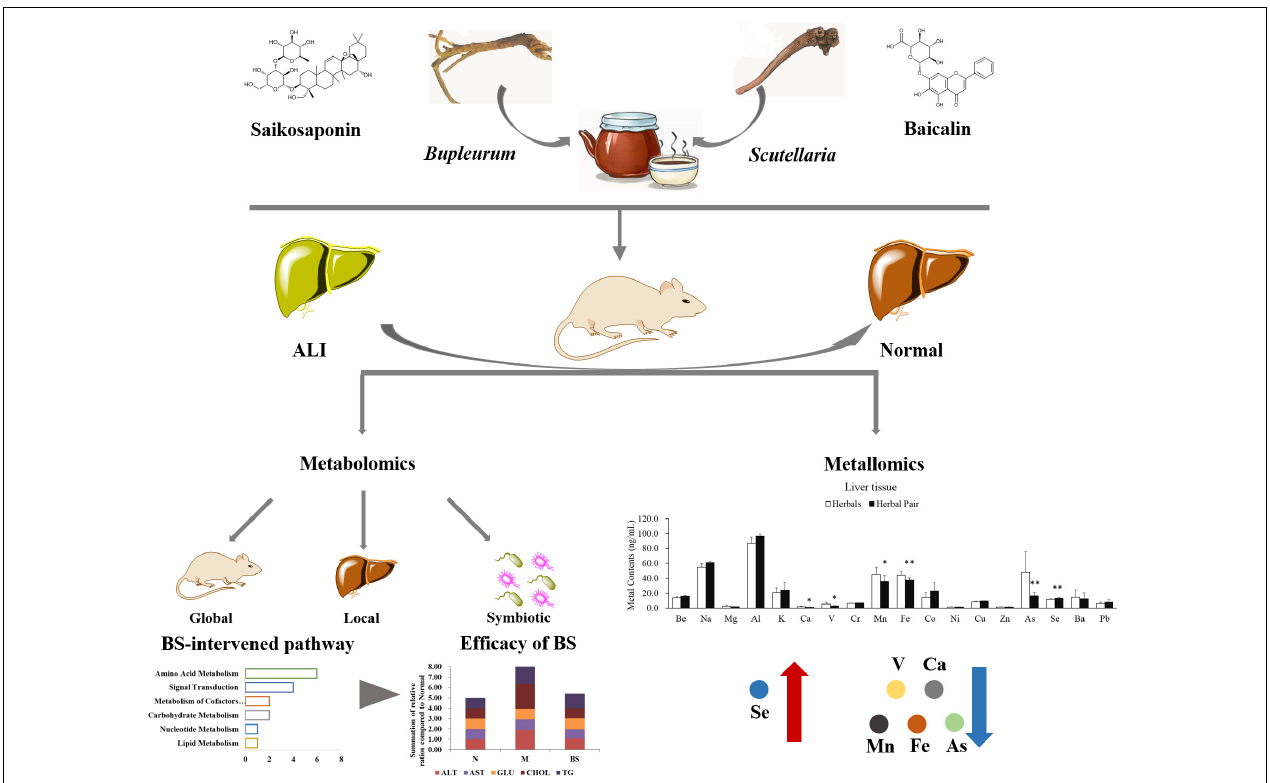
FIGURE 4 | Schematic diagram of the combined effects of the B. chinense-S. baicalensis herbal pair in Alcoholic Liver Injury. Alcoholic Liver Injury was used to research the characteristics of B. chinense- S. baicalensis , which is controlled by B. chinense and S. baicalensis , and their main active ingredients baicalin and saikosaponin. The biochemical indicators and histology indicated that B. chinense-S. baicalensis presented the best efficacy, which could be further illustrated by global, local, and symbiotic metabolic analysis. Finally, metallomic analysis was employed to uncover the distribution changes of selenium which, unlike other metal elements, was significantly increased by B. chinense-S. baicalensis in liver tissue to demonstrate multiple benefits such as anti-oxidative stress and hepatoprotective effect, to relieve drug